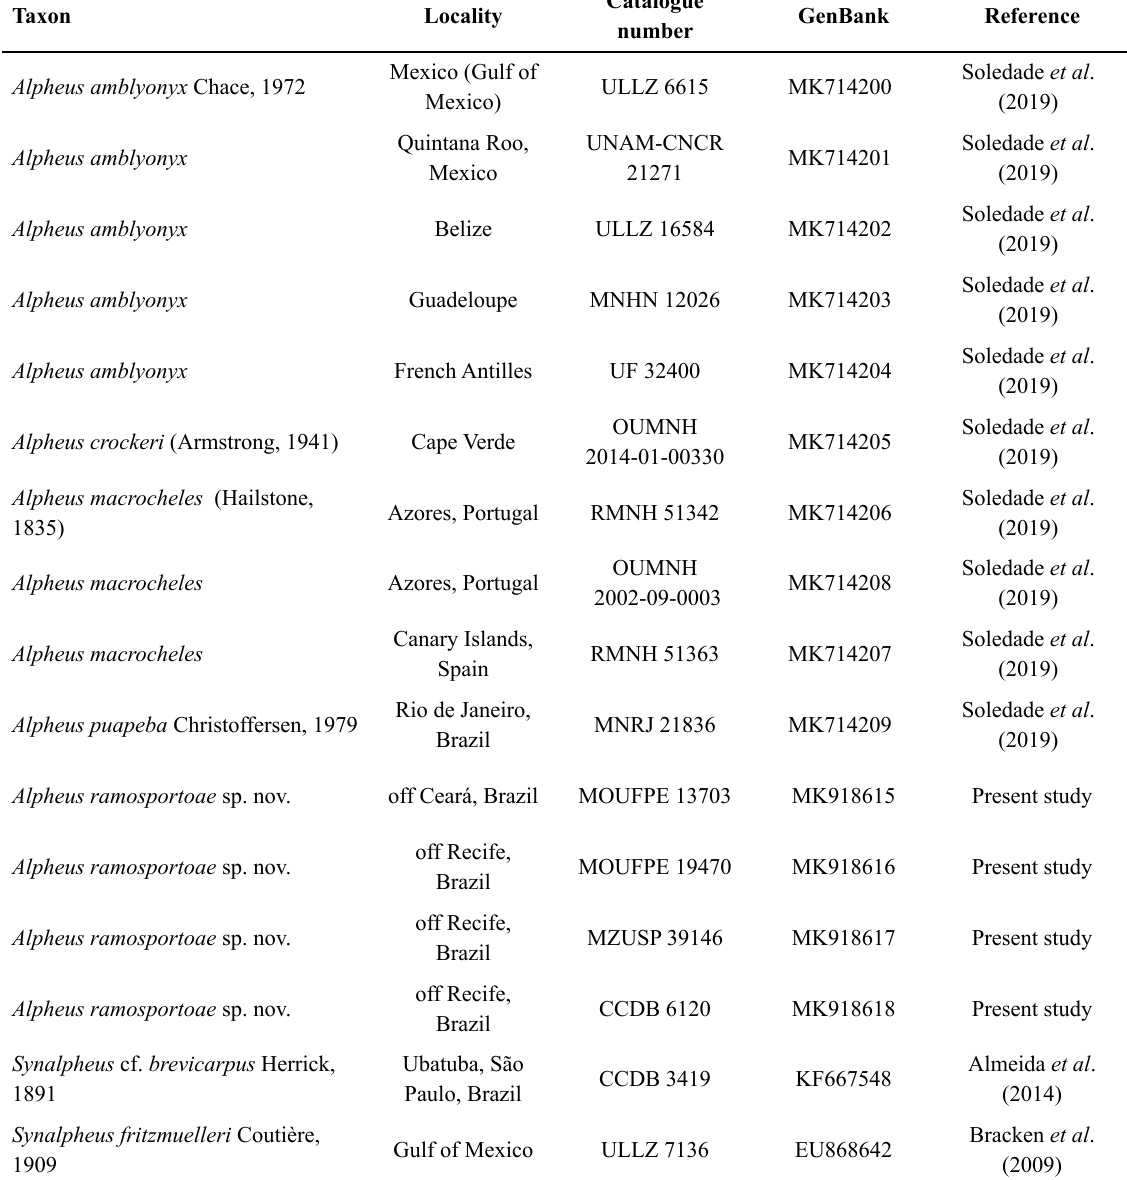
Table 1. List of specimens used in genetic analysis. Abbreviations: CCDB = Coleção de